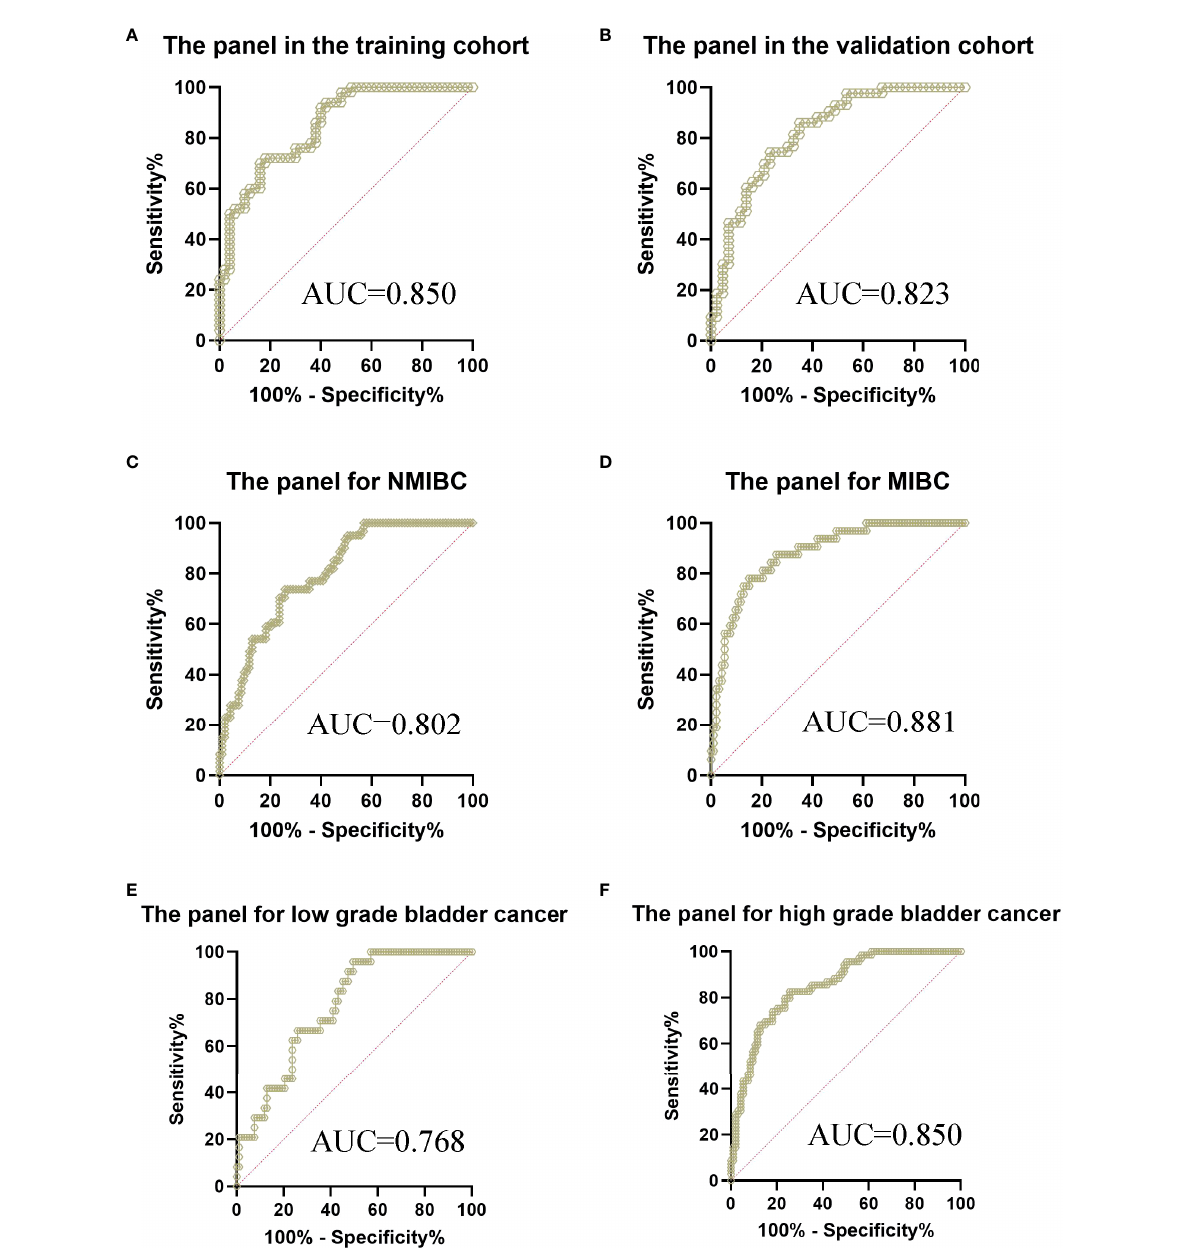
FIGURE 4 ROC curve analysis of the panel for the diagnosis of bladder cancer from controls. (A) The panel in the training cohort, AUC=0.850 (B) The panel in the validation cohort, AUC=0.823 (C) The panel for the diagnosis of NMIBC from controls, AUC=0.802 (D) The panel for the diagnosis of MIBC from controls, AUC=0.881 (E) The panel for the diagnosis of low grade bladder cancer from controls, AUC=0.768 (F) The panel for the diagnosis of high grade bladder cancer from controls,